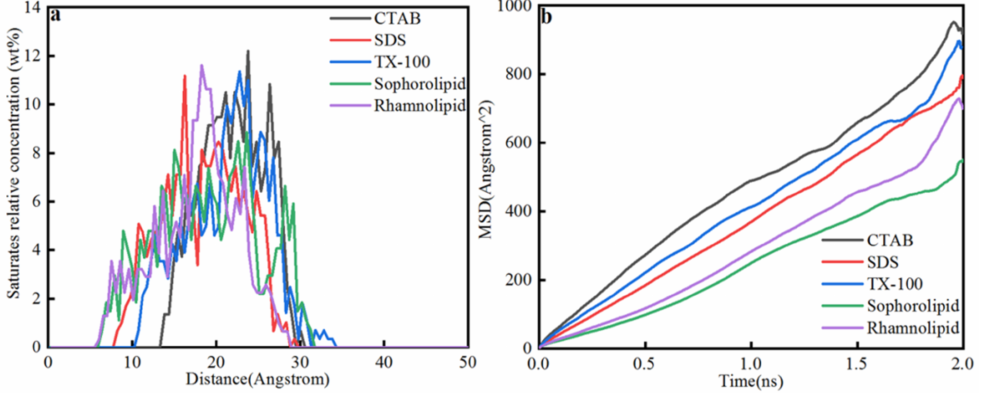
Figure 10. ( a ) Saturates relative concentration; ( b ) Mean square